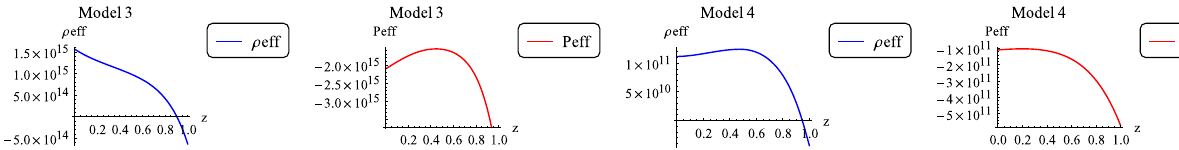
Fig. 8 The energy density ρ ef f and pressure p ef f in terms of red-shift under different viable models